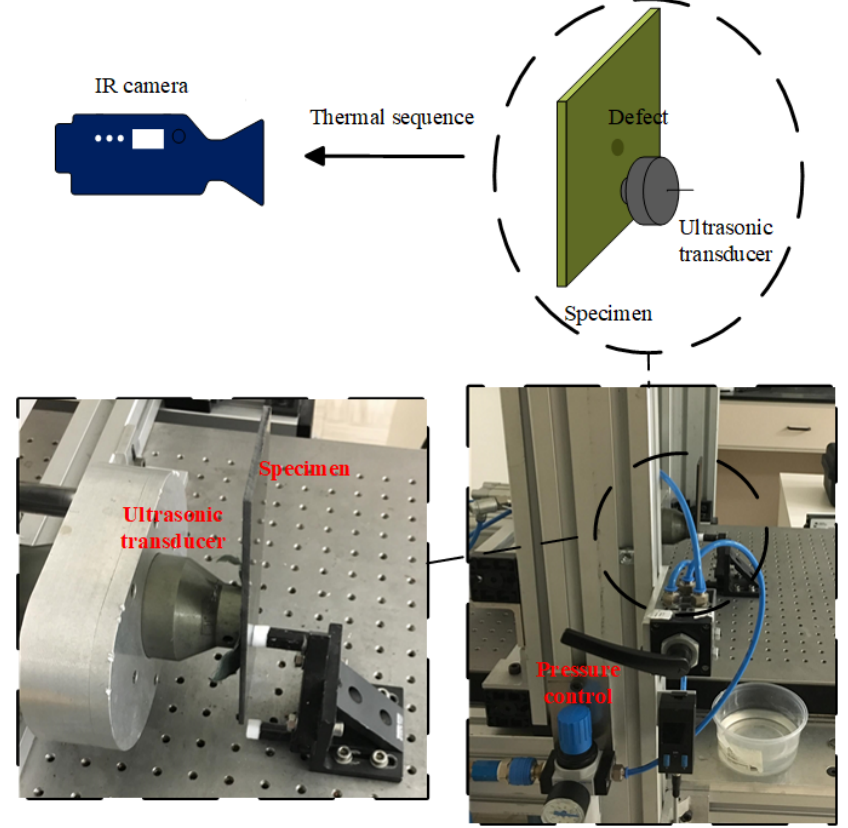
Figure 4. Experimental configuration for vibro ‐ thermography inspection.